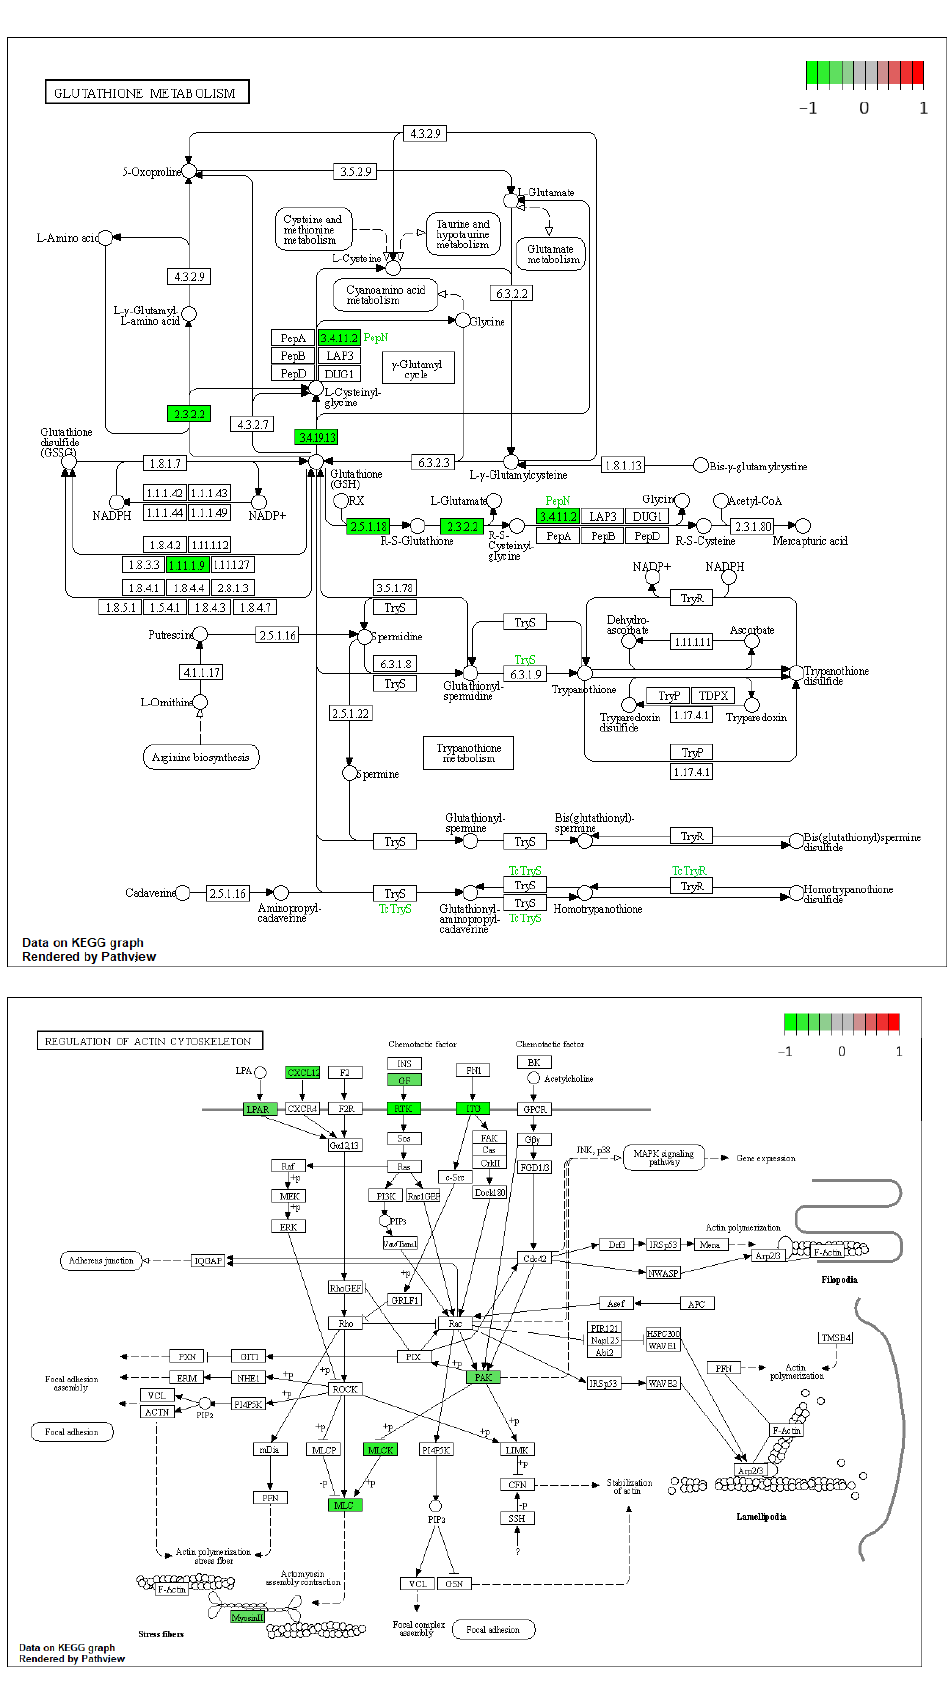
Figure 13. Visualization of the pathways [25]. Green boxes are downregulated genes.